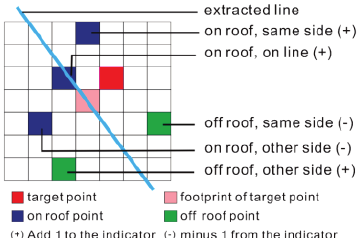
Figure 3. Calculation of the indicator from extracted